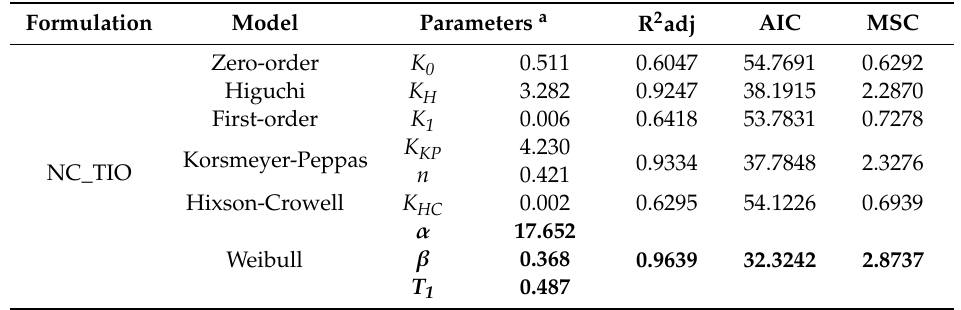
Table 2. Kinetic parameters obtained after fitting curves for di ff erent release models to the release data from the NC_TIO.